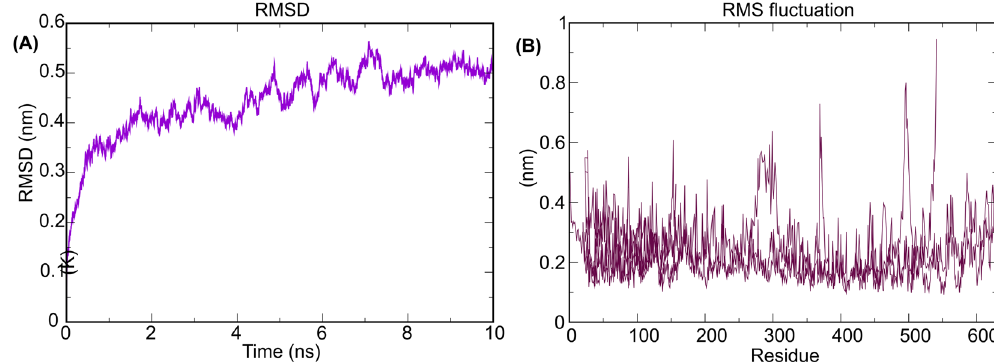
Figure 6. Molecular dynamics simulation output of vaccine protein-TLR-4 docked complex. ( A ) RMSD obtained for the complex backbone showing that initially, RMSD increased up to 8 nanoseconds after that become stable at 0.5 nanometers, while ( B ) showing an average RMSF of 0.2 for the side chain residues of the docked